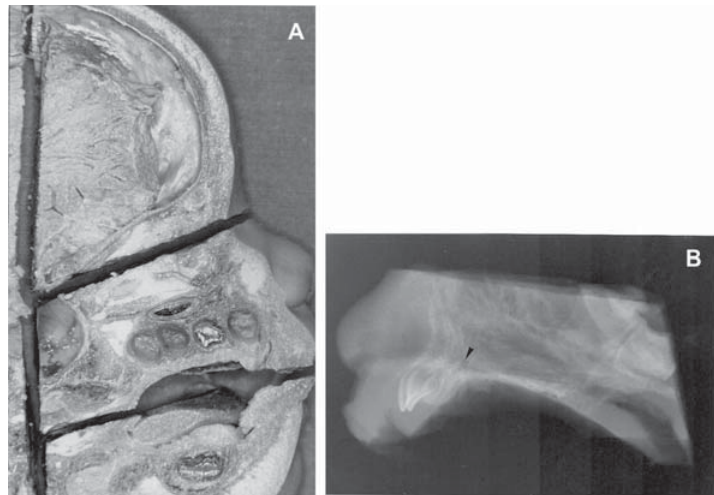
Figure 1- (cid:2)(cid:3)(cid:4)(cid:5)(cid:6)(cid:2)(cid:7)(cid:8)(cid:9)(cid:10)(cid:11)(cid:9)(cid:12)(cid:8)(cid:13)(cid:2)(cid:11)(cid:14)(cid:2)(cid:15)(cid:8)(cid:16)(cid:13)(cid:2)(cid:11)(cid:10)(cid:2)(cid:10)(cid:8)(cid:5)(cid:4)(cid:6)(cid:2)(cid:10)(cid:11)(cid:9)(cid:2)(cid:15)(cid:17)(cid:6)(cid:5)(cid:11)(cid:18)(cid:11)(cid:19)(cid:17)(cid:20)(cid:16)(cid:18)(cid:2)(cid:7)(cid:9)(cid:11)(cid:20)(cid:8)(cid:6)(cid:6)(cid:17)(cid:14)(cid:19)(cid:2)(cid:17)(cid:14)(cid:2)(cid:21)(cid:22)(cid:2)(cid:23)(cid:16)(cid:5)(cid:8)(cid:9)(cid:16)(cid:18)(cid:2)(cid:9)(cid:16)(cid:13)(cid:17)(cid:11)(cid:19)(cid:9)(cid:16)(cid:7)(cid:15)(cid:2)(cid:11)(cid:10)(cid:2)(cid:24)(cid:14)(cid:16)(cid:18)(cid:2)(cid:7)(cid:17)(cid:8)(cid:20)(cid:8)(cid:2)(cid:9)(cid:8)(cid:25)(cid:8)(cid:16)(cid:18)(cid:17)(cid:14)(cid:19)(cid:2) trajectory of incisive canal in B